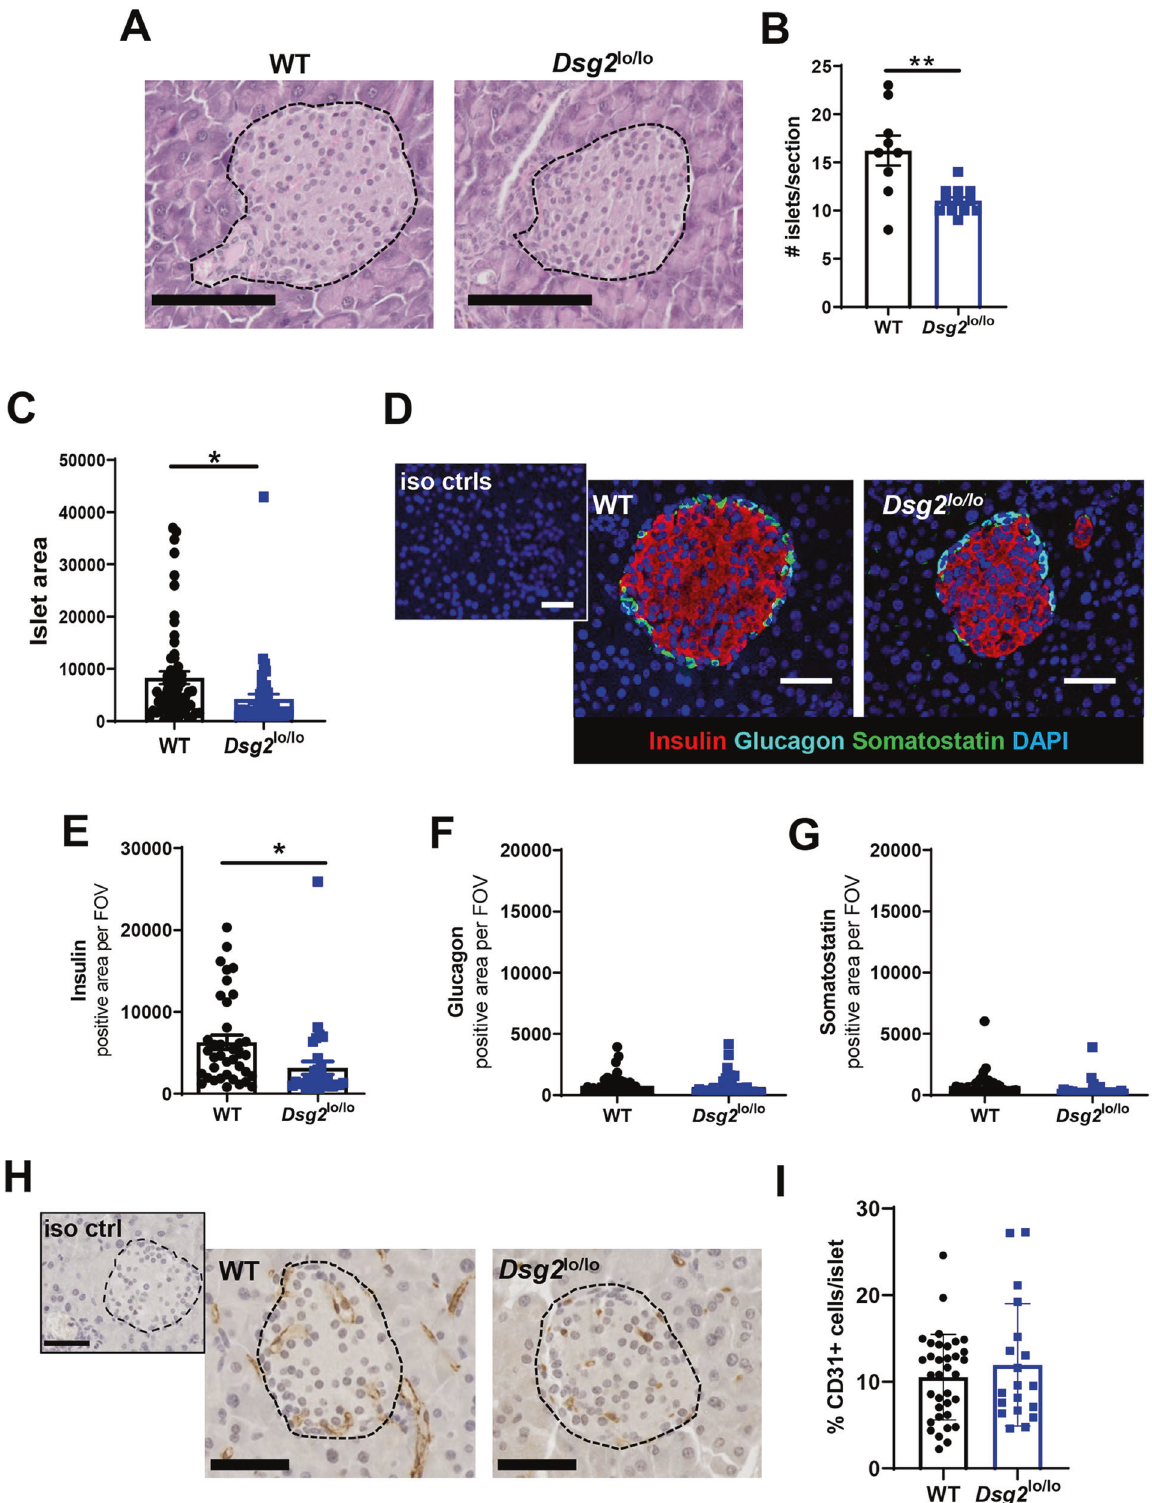
and eosin to identify islet clusters (Fig. 3A). The number of islets were counted from three geographically distinct sections span- ning across the pancreas (i.e. head to tail), and suggest that compared WT mice, Dsg2 lo/lo mice have signi fi cantly fewer islets throughout their pancreas (Fig. 3B). We also observed that the Dsg2 lo/lo islets were signi fi cantly smaller in size compared to the